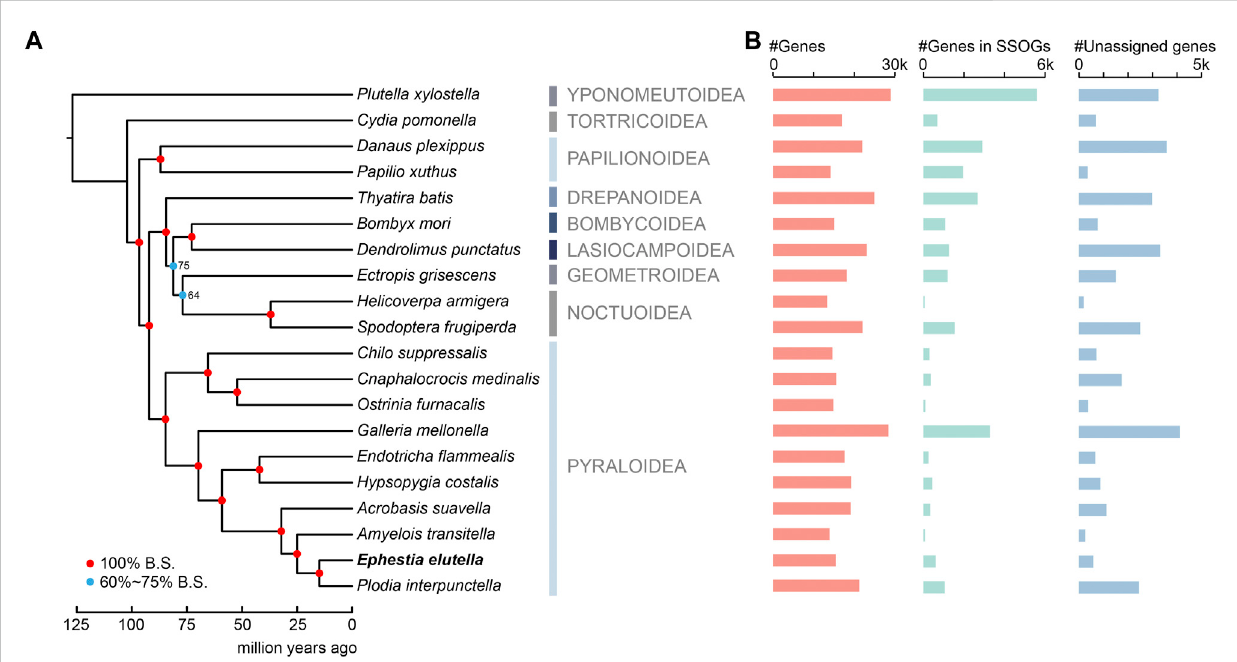
FIGURE 1 Phylogenetic relationship and orthology comparison of the tobacco moth Ephestia elutella and 19 lepidopteran species. (A) A maximum-likelihood phylogenetic tree constructed using concatenated protein sequences of 1,864 orthogroups identi fi ed by STAG algorithm and 6 calibration points. The color-coding nodes of the phylogenetic tree indicate bootstrap support scores. (B) Gene number comparisons of protein-coding genes, genes in species-speci fi c orthogroups (SSOGs) and unassigned genes among the 20 lepidopterans in this